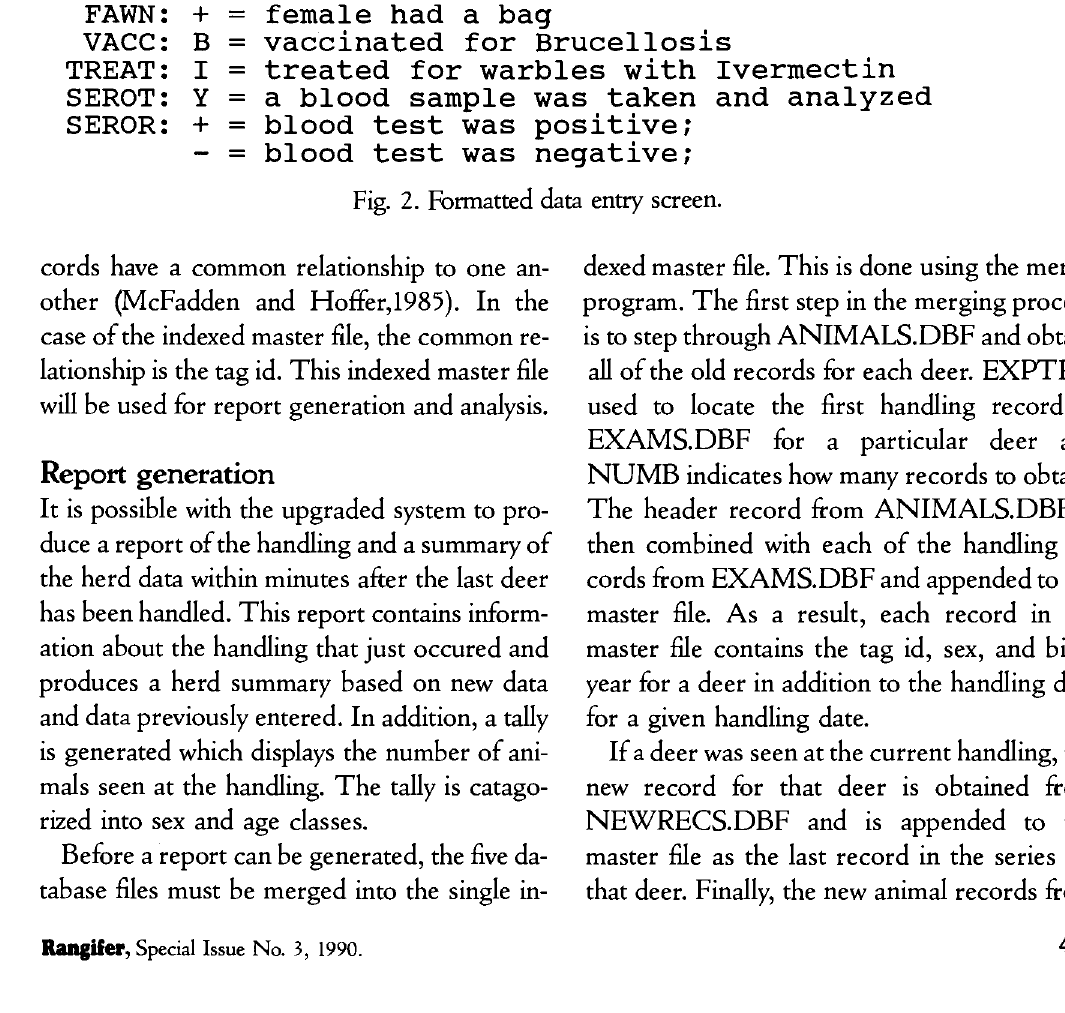
Fig. 2. Formatted data entry